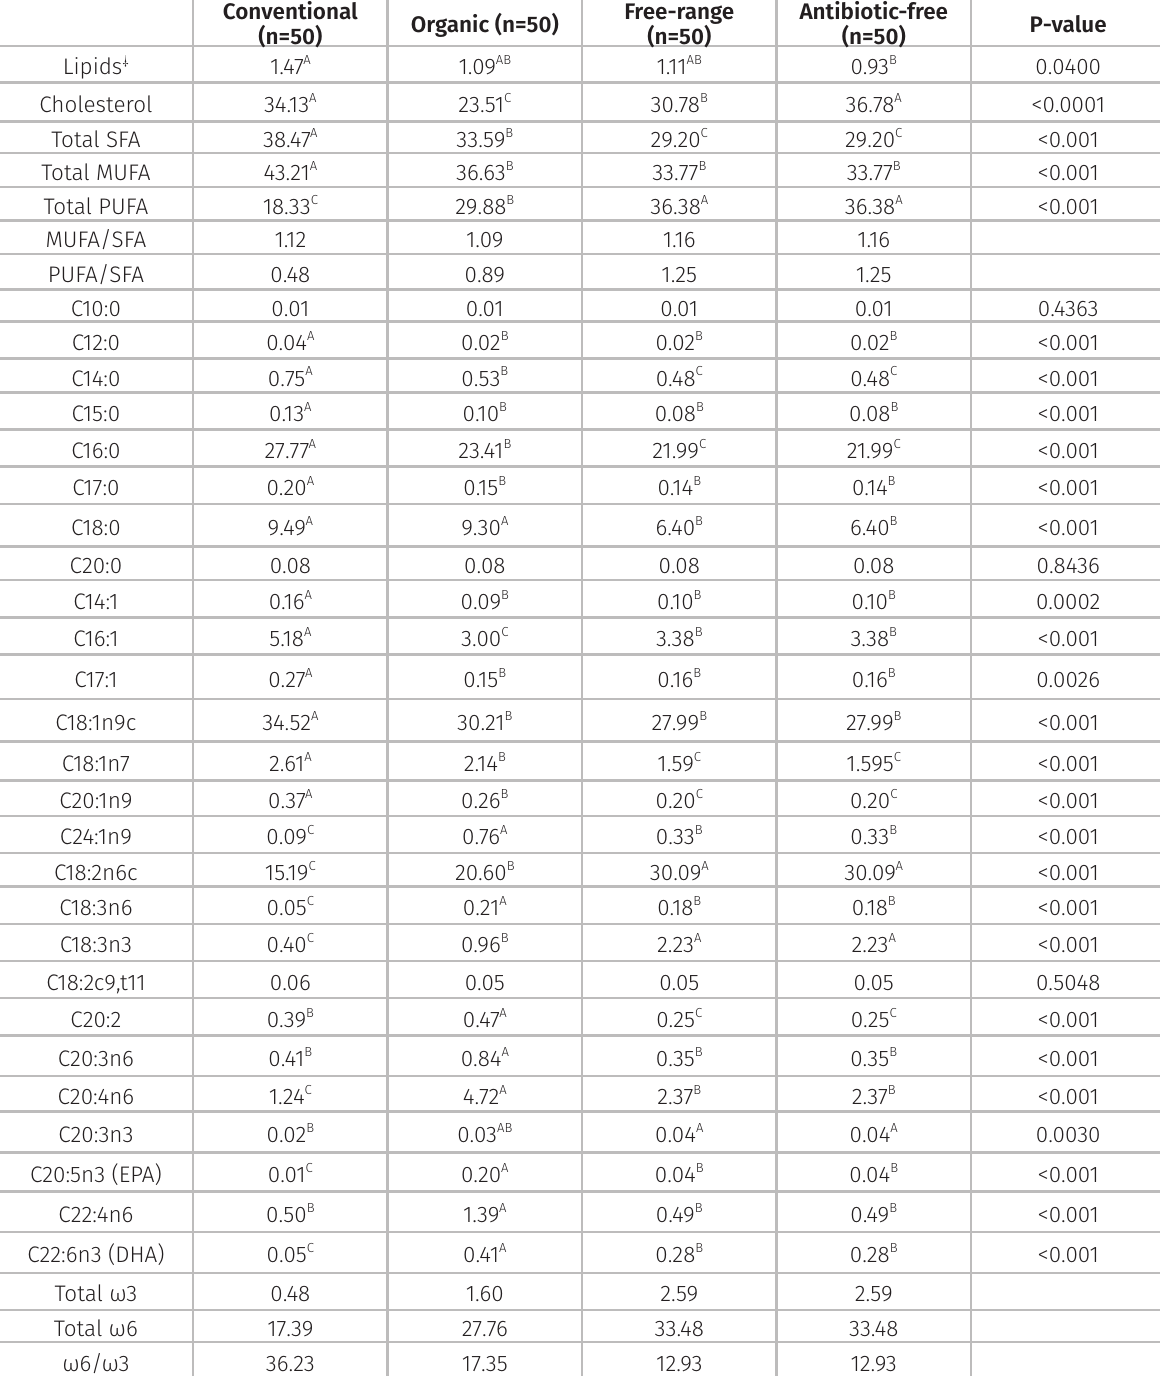
Table II. Lipids (%) and cholesterol (mg/100g) of breast meat and fatty acid composition (% of total fatty acids) of fat from breast meat from broilers raised in different rearing